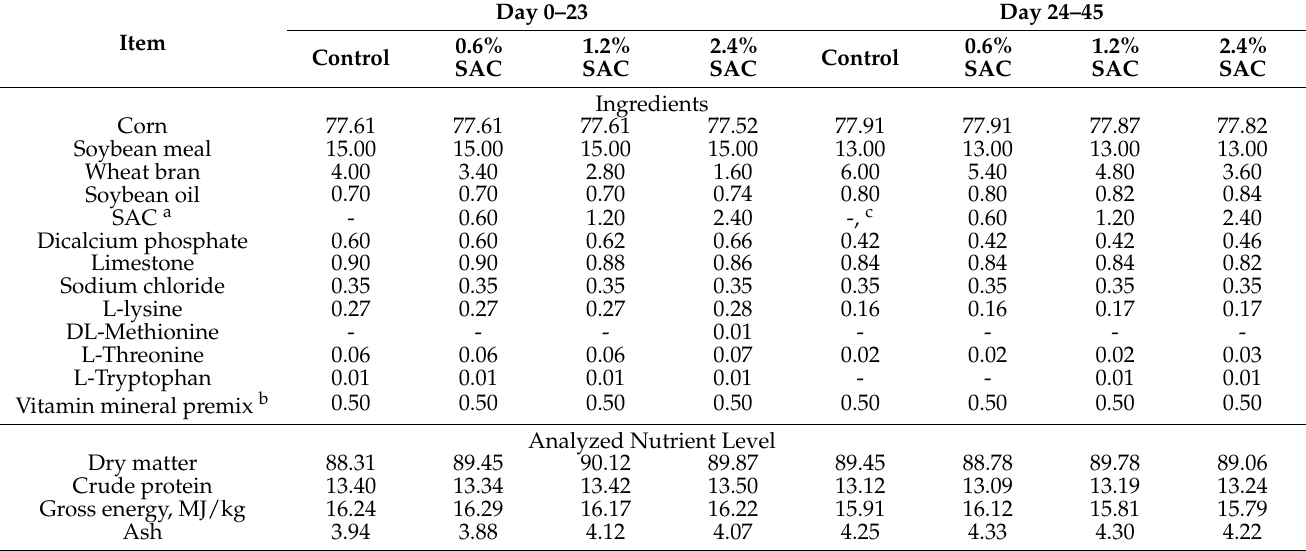
Table 3. Ingredients and calculated nutrient levels of the treatment diets used in Exp. 2 (%, as-fed basis).